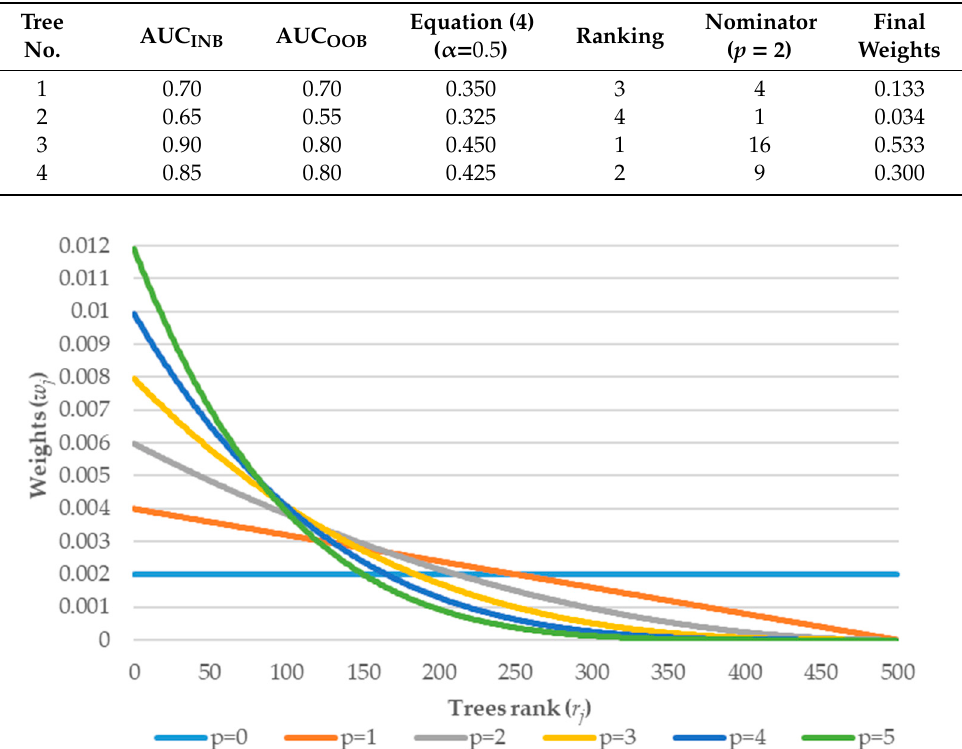
Figure 1. Weights distribution in terms of number of trees and value of the parameter p .